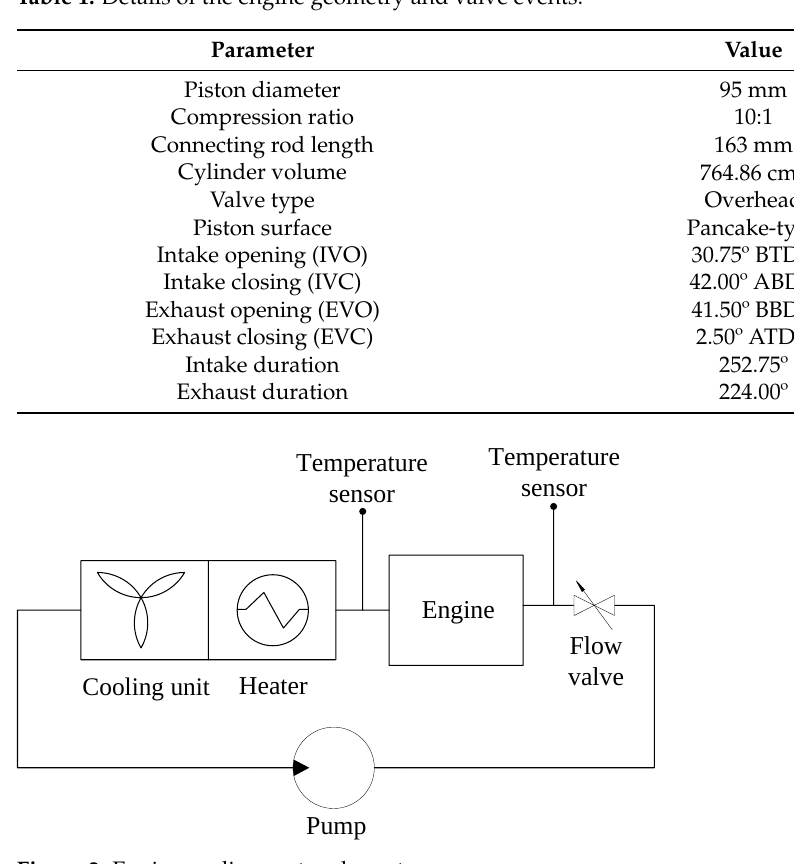
Figure 1. Engine test cell. Table 1. Details of the engine geometry and valve events.